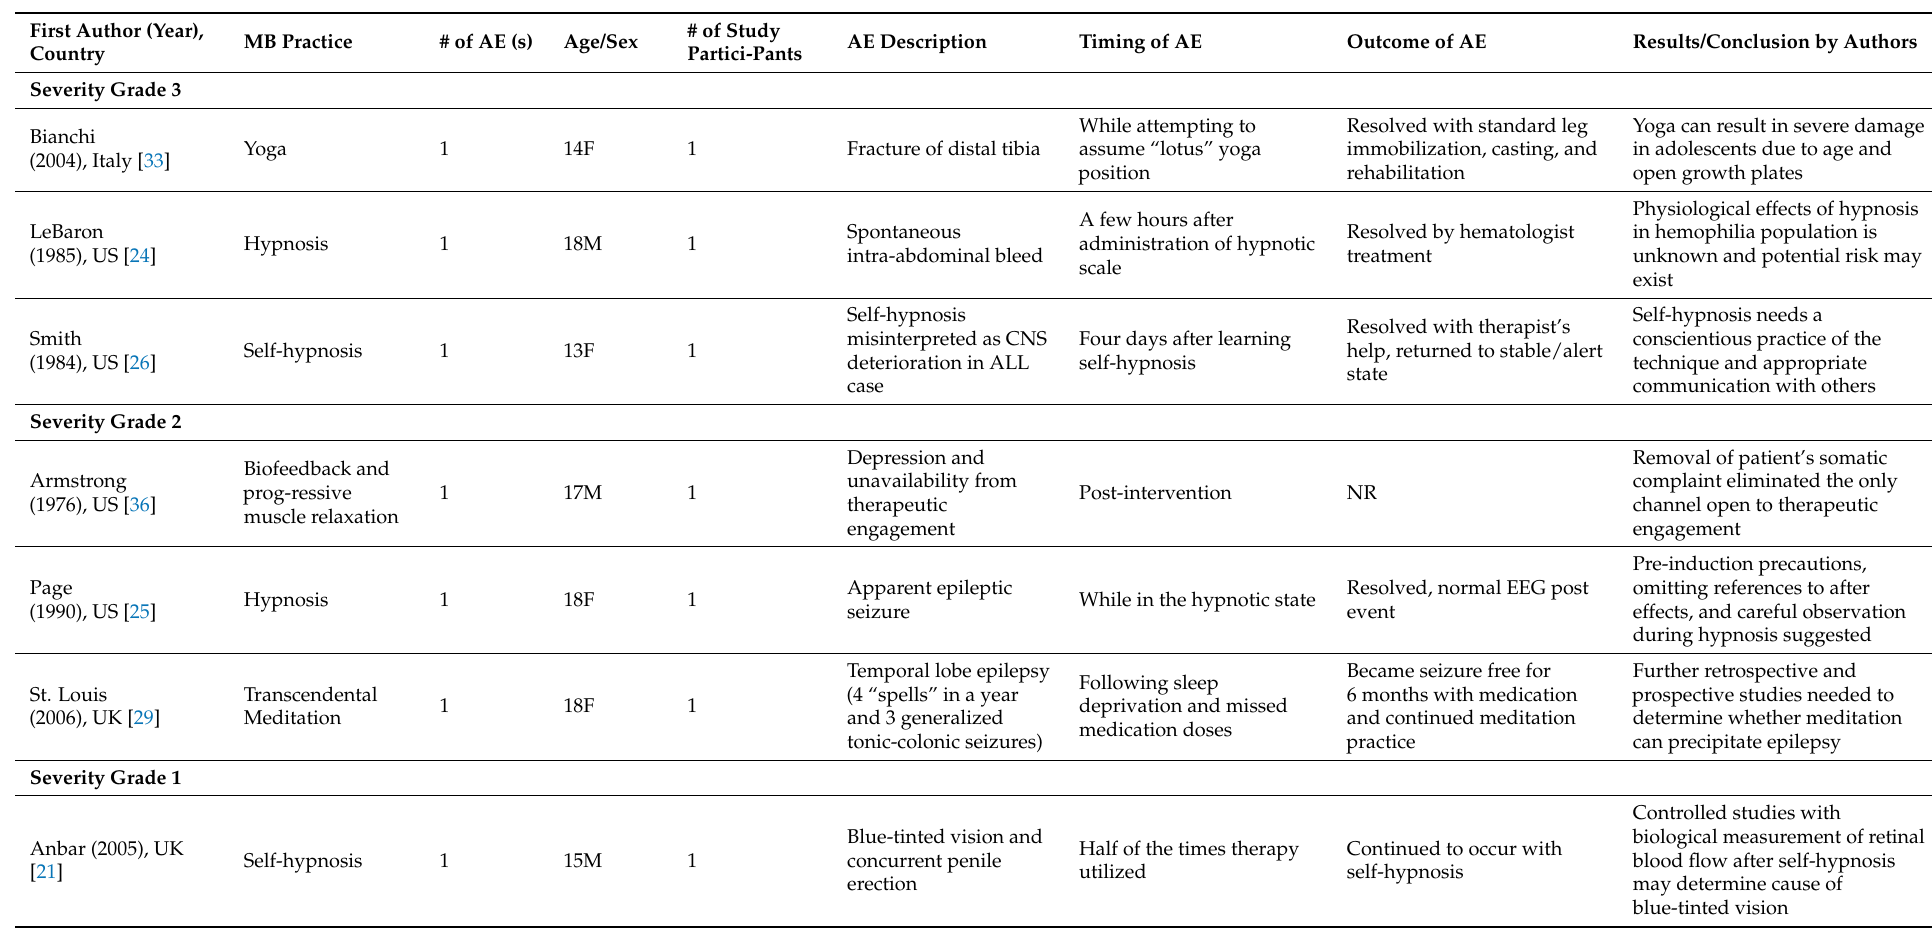
Table 2. Summary of adverse events following mind-body practices in pediatrics by severity